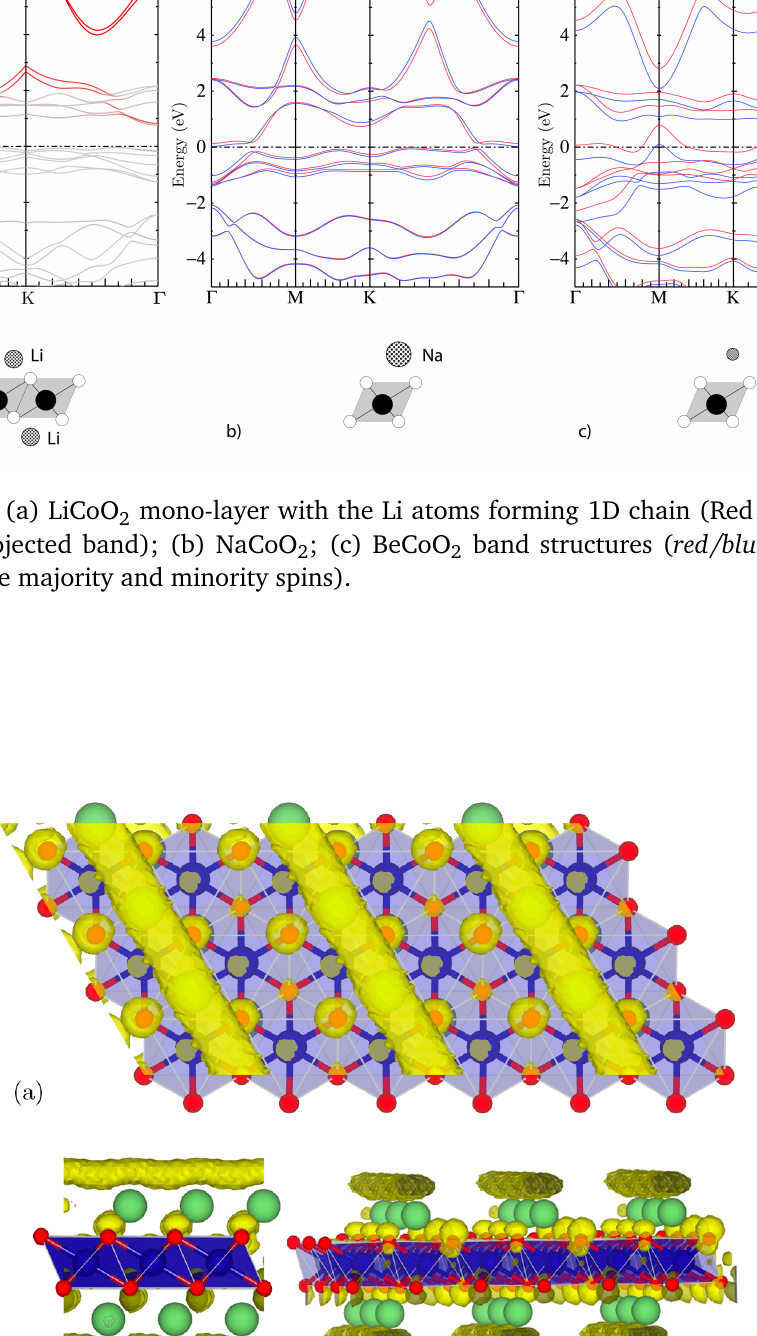
monolayer with Li on either side but 2 . yellow isosurface of the electron 2